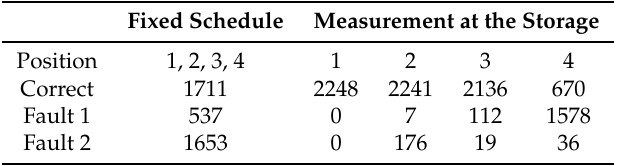
Table 8. Results for the scenario with measurements at the storage.